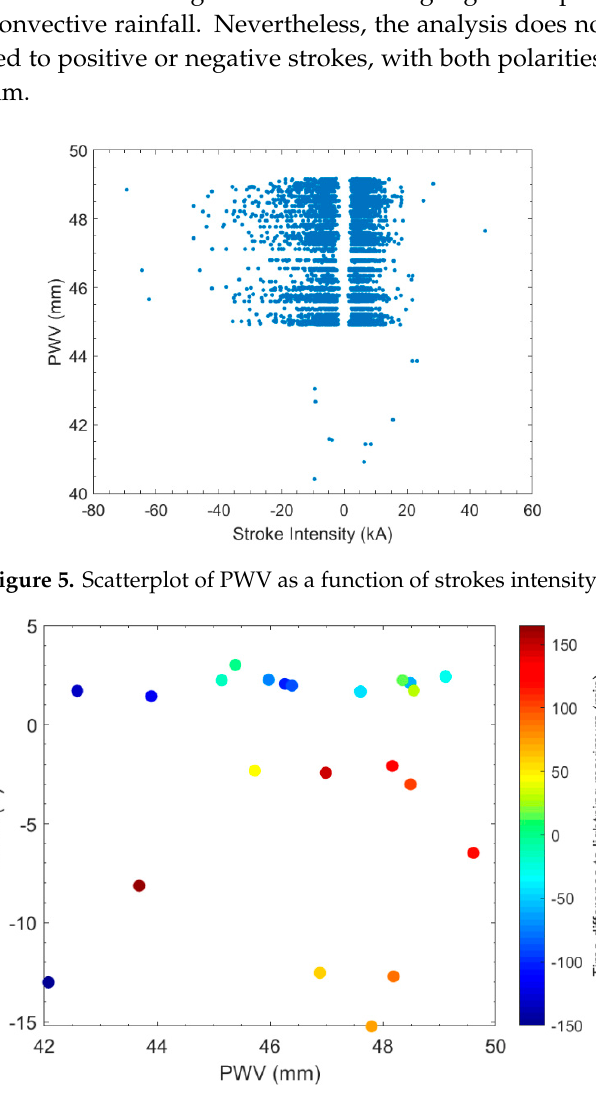
Figure 6. Scatterplot of ∆ TB with respect to PWV as a function of time di ff erence with respect to the main lightning activity.